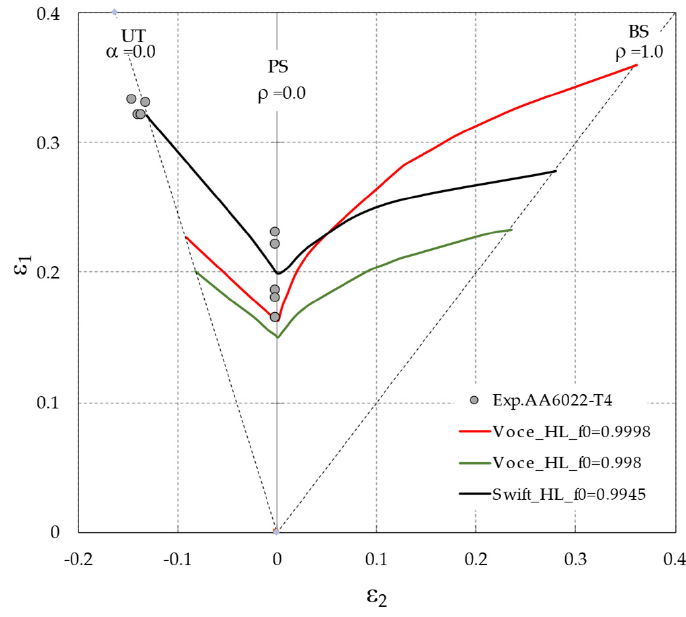
Figure 16. Experimental and theoretical FLDs of AA6022-T4 sheet using the YLD2000-2d yield function with the Voce law and the Swift law.